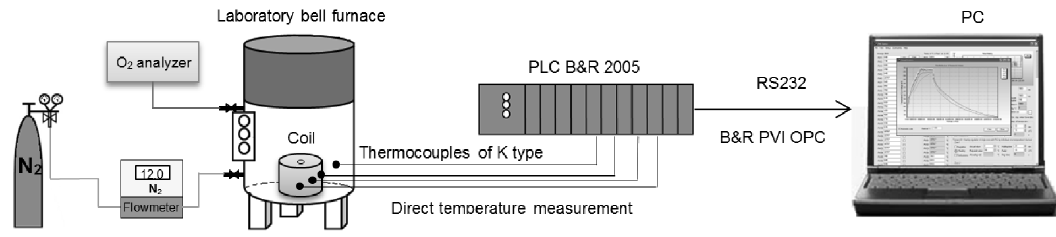
Figure 1. The scheme of the measuring chain for laboratory